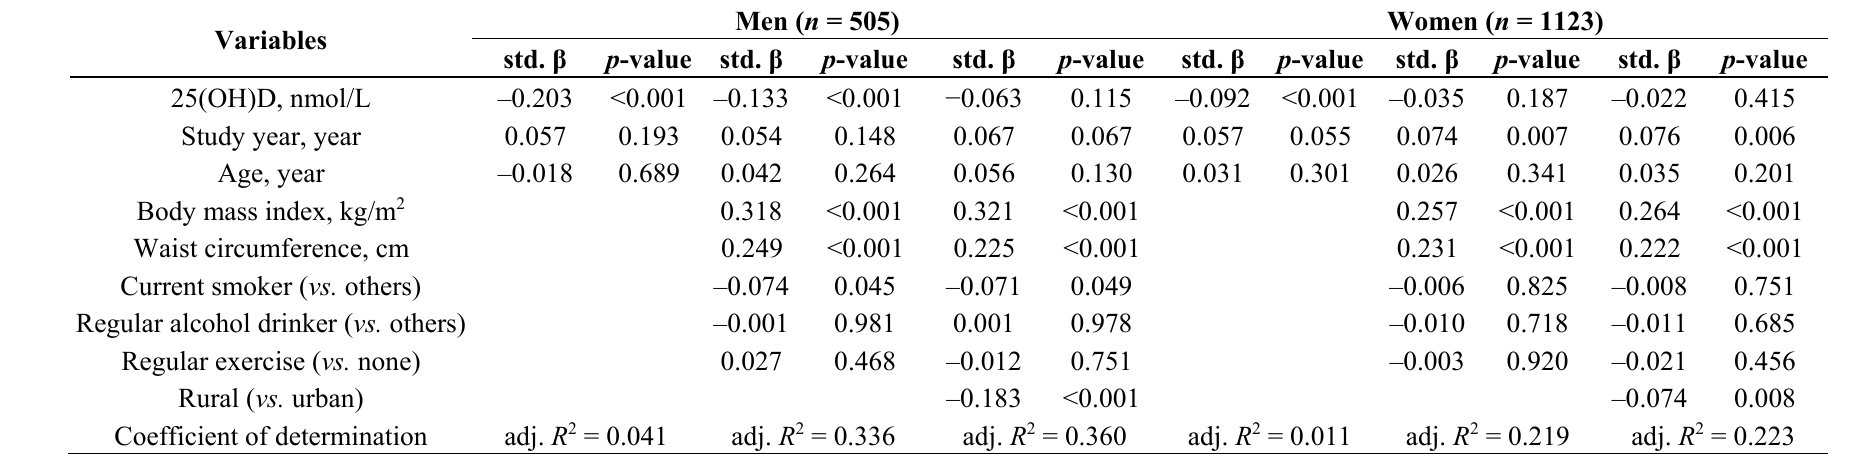
Table 5. Association between log-transformed serum 25(OH)D and log-transformed HOMA-IR in men and women. Variables